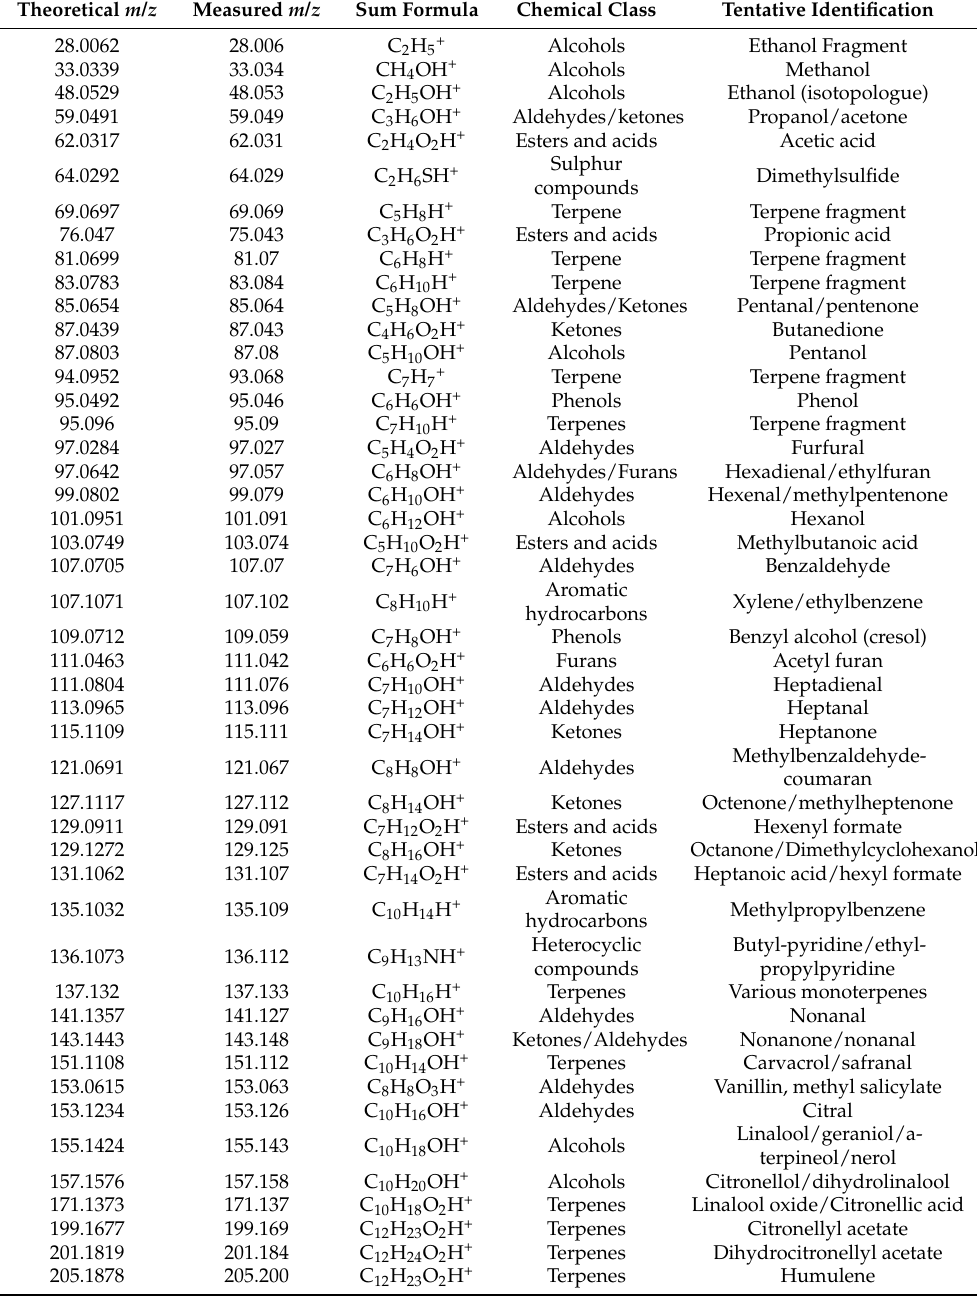
Table 2. List of the peaks identified with PTR-ToF-MS. The measured mass, the identified mass, the sum formula and a tentative identification are